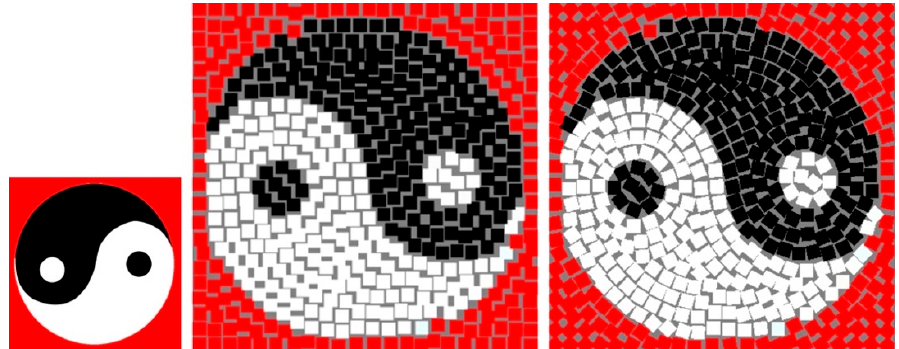
Figure 18. Synthesis results without (middle) and with (right) the vector field. (The element’s directions in the right image are controlled by the vector field extracted from the left image.).